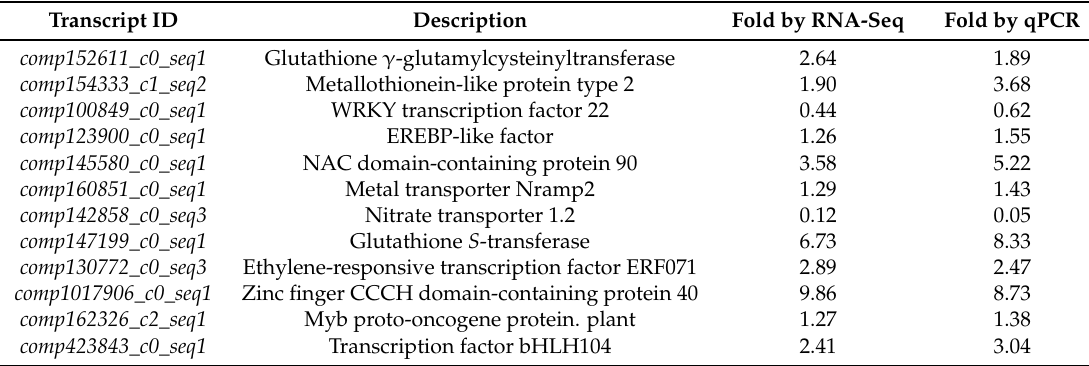
Table 5. Validation of the RNA-Seq expression profiles of selected DEGs using